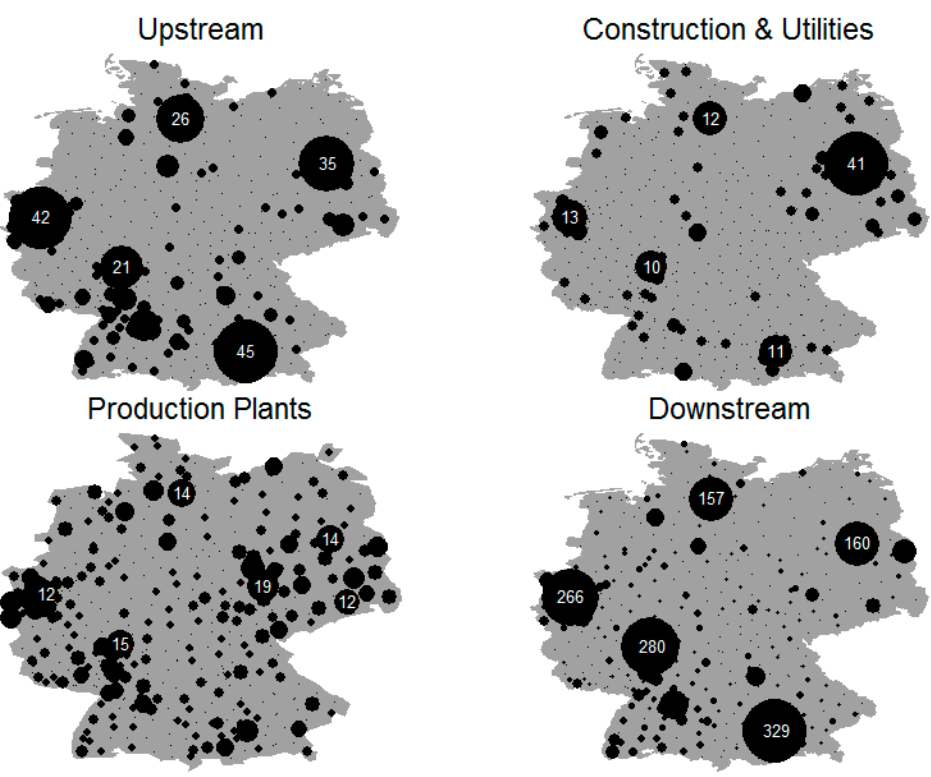
Figure 2. Distribution of greenfield FDI across German districts by function.